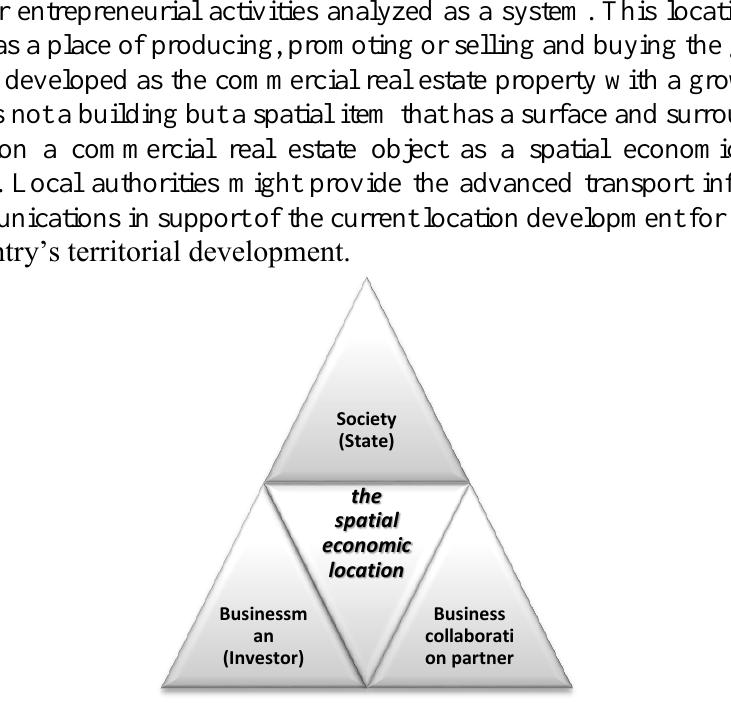
Fig. 2. Scheme of spatial economic location’s identification in the system of entrepreneurial activities [developed by